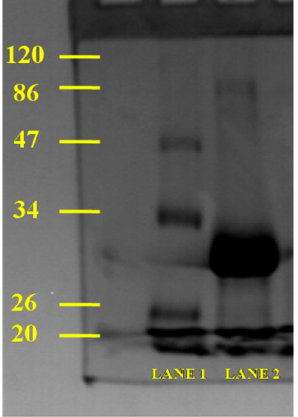
Figure 5. SDS ‐ PAGE analysis of protease. Lane 1: molecular weight marker (BSM0441, pre ‐ stained Figure 5. SDS-PAGE analysis of protease. Lane 1: molecular weight marker (BSM0441, pre-stained 20–120 kDa mid ‐ range protein molecular weight marker); Lane 2: sample (purified protease). 20–120 kDa mid-range protein molecular weight marker); Lane 2: sample (purified